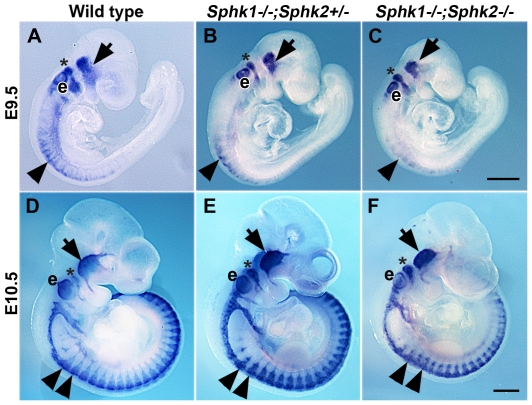
Deleting Sphk1 and Sphk2 does not alter neural crest migration pattern.
Sox10 whole mount in situ hybridization was performed on wild type, Sphk1−/−;Sphk2+/−, and Sphk1−/−;Sphk2−/− embryos at E9.5 (22–25 somites) and E10.5 (32–35 somites). (A–C) At E9.5, Sox10 expression can be detected in the forming trigeminal ganglia (arrow), hindbrain neural crest (asterisk) as well as the developing ear (e). Trunk neural crest cells are beginning to migrate in the first few somites (arrowhead). Embryos from all three genotypes show similar Sox10 staining pattern even though the Sphk1−/−;Sphk2−/− embryo is slightly smaller (C). (D–F) At E10.5, trunk neural crest migration (arrowhead) is well underway and can be visualized by Sox10 staining. Trigeminal ganglia (arrow) and hindbrain neural crest cells (asterisk) can be identified at this stage. Sox10+ neural crest cells are present in the Sphk1−/−;Sphk2−/− embryo and they display the stereotypical segmental migration pattern similar to the wild type embryo although the stream of neural crest cells in Sphk1−/−;Sphk2−/− double mutant embryo appears narrower comparing to wild type and Sphk1−/−;Sphk2+/− embryos. The ear (e) continues to express Sox10. Scalebars for A–C and D–F = 500 µm.